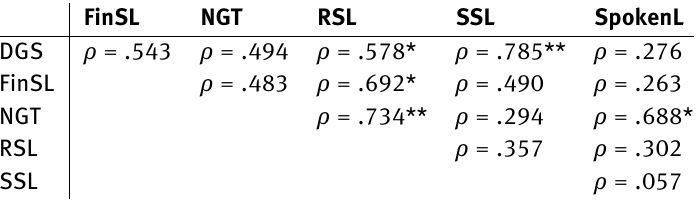
Table 2: The statistical rank correlation across ValPaL verb meanings within each language dyad for our five sign languages and the combined spoken languages from Haspelmath (2015). Locative arguments are included for the sign languages.